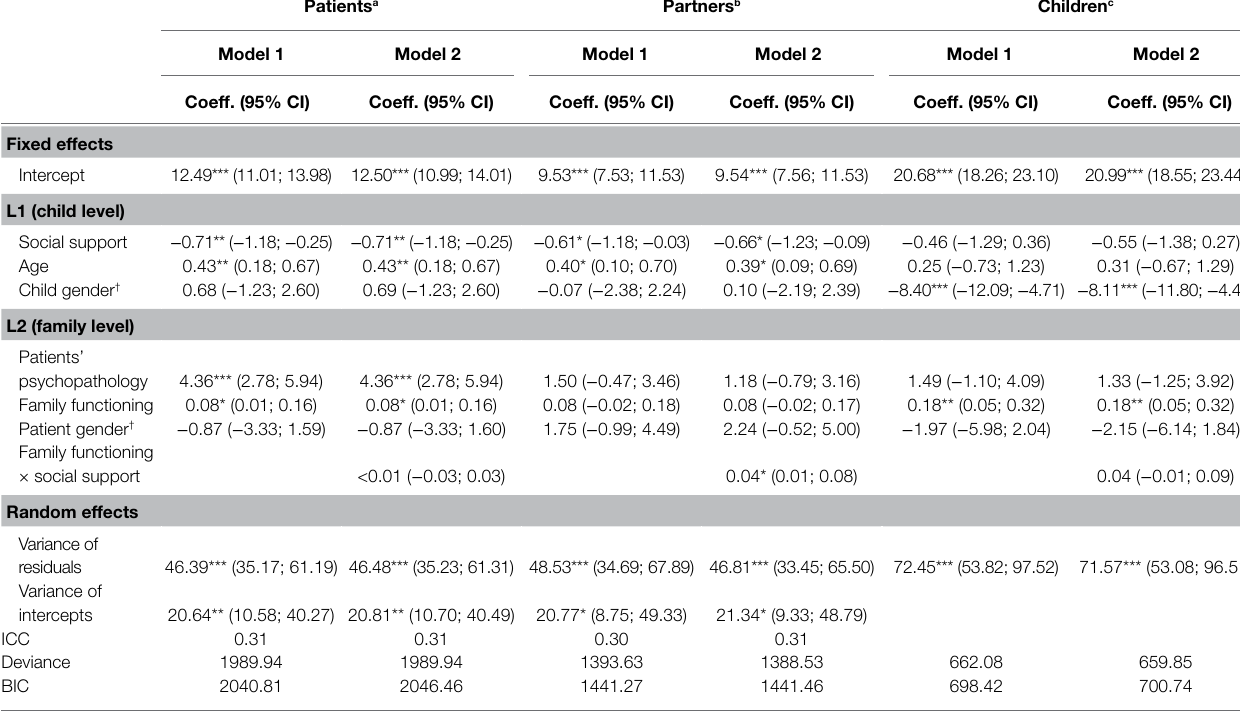
TABLE 3 | Associations with child internalizing problems from the three different rating perspectives.